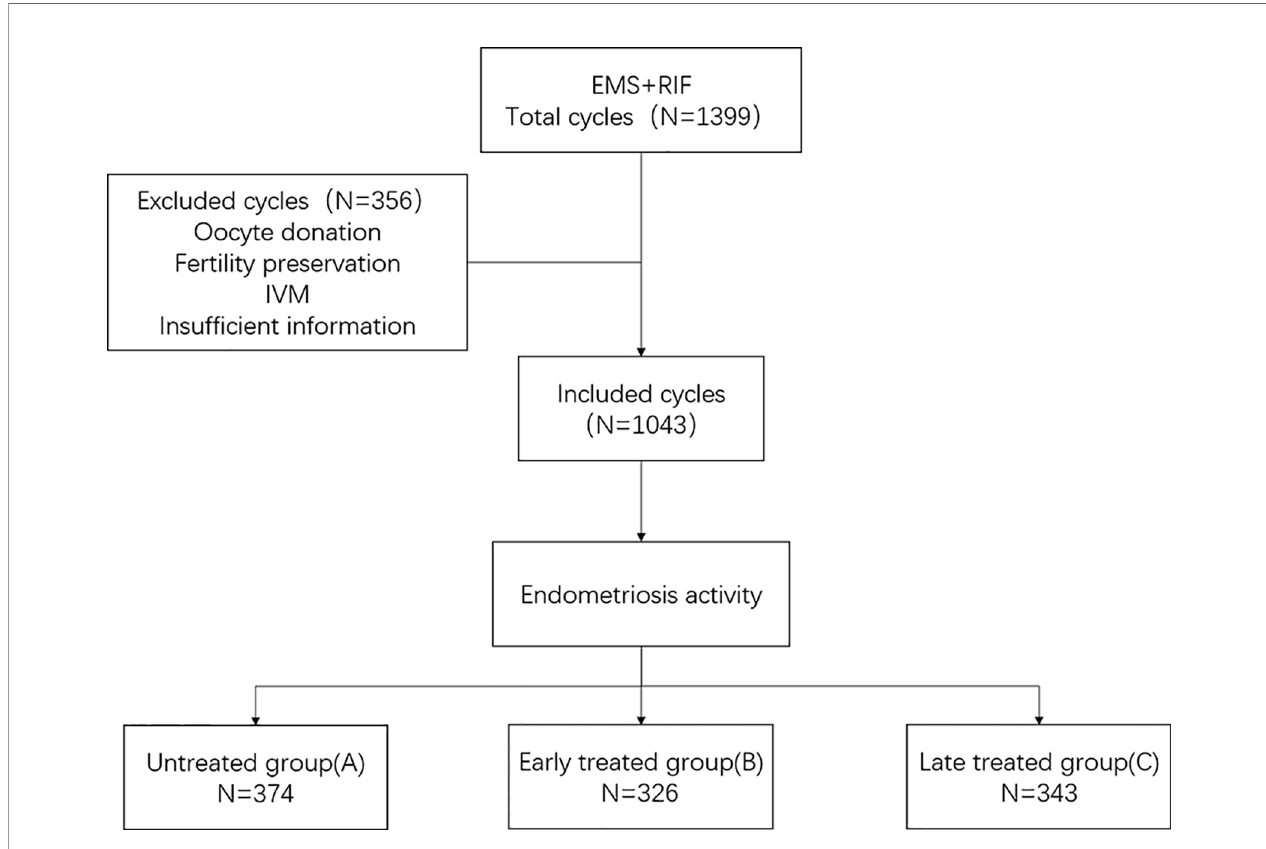
FIGURE 1 | Flowchart of study recruitment and inclusion/exclusion